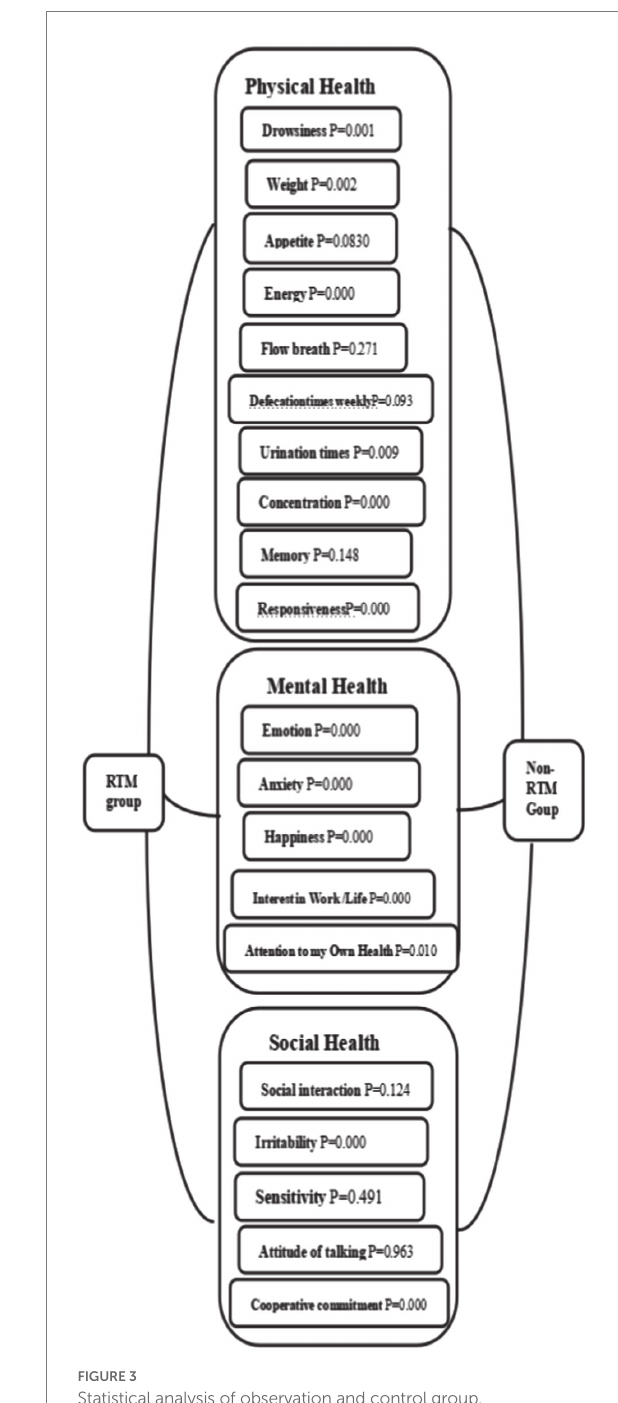
FIGURE 3 Statistical analysis of observation and control